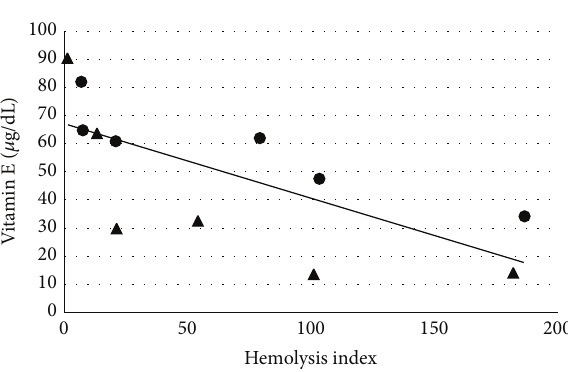
Figure 1: Least squares means serum vitamin E concentrations ( 𝜇 g/dL) versus induced serum hemolysis index in 2 adult male alpacas. Alpaca A is represented by the solid circle and alpaca B by the solid triangle. A best-fit line, corresponding to correlation coefficient of − 0.69, is present.